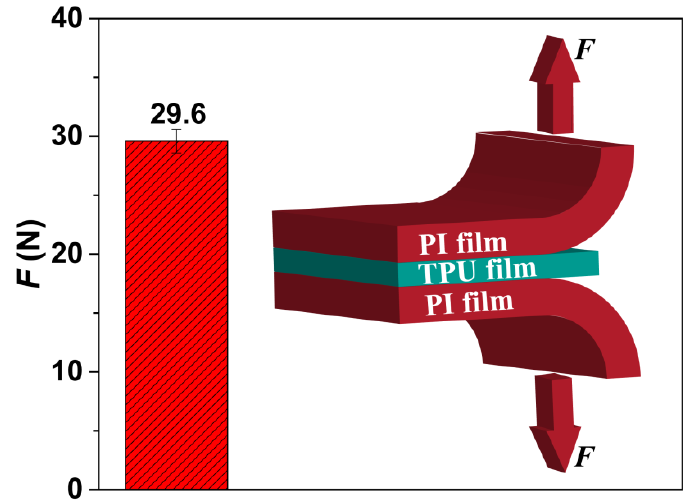
Figure 8. The peel strength of PI/TPU/PI sandwich film, including an insert schematic